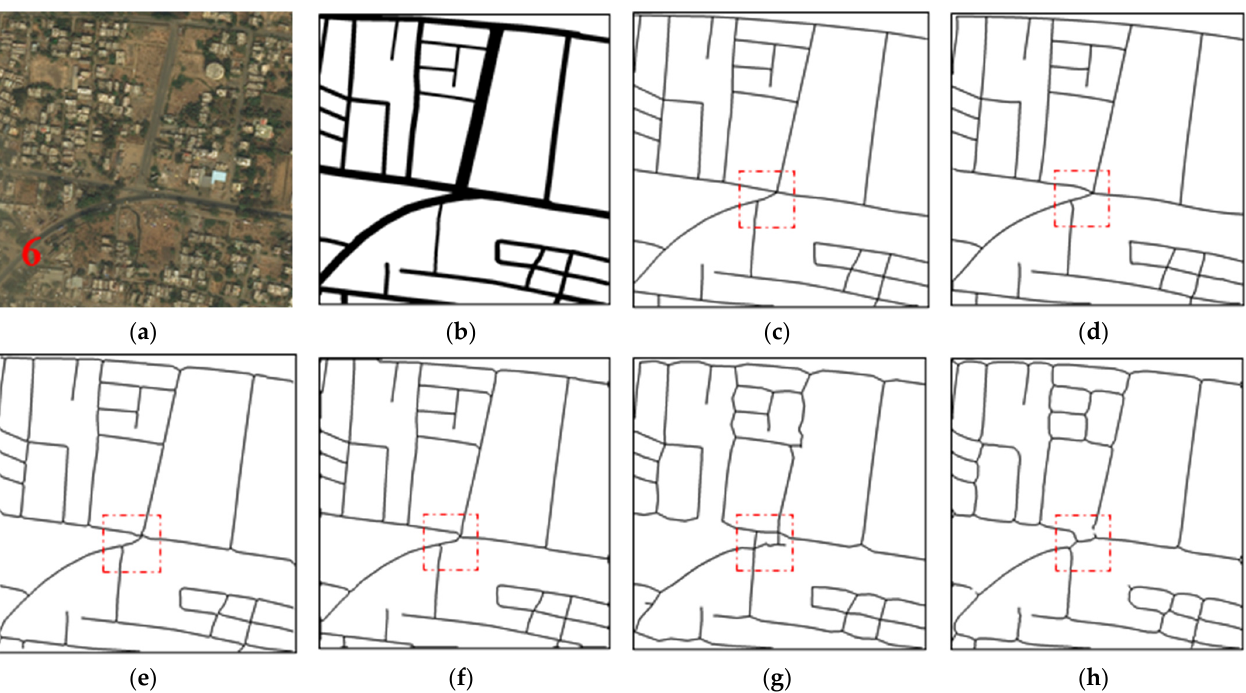
Figure 14. Experimental results for test image 6. ( a ) Original optical image. ( b ) Labelled road map. ( c ) Reference centerline map. ( d ) Result of the proposed method. ( e ) Result of the MT method. ( f ) Result of the ZST method. ( g ) Result of the MARS method. ( h ) Result of the NMS method.